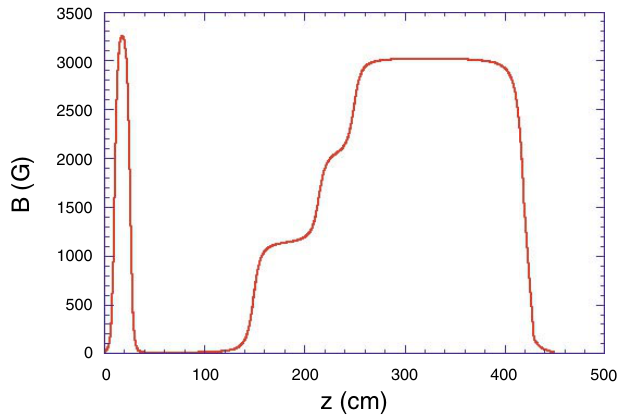
FIG. 3. (Color) The z dependence of the longitudinal magnetic field used in the PARMELA simulation of the ORION photo- injector.